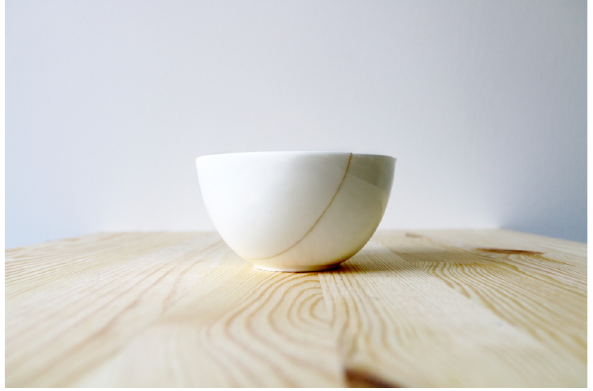
Figure 1 | Photo of “Chrysalis Gemini”.